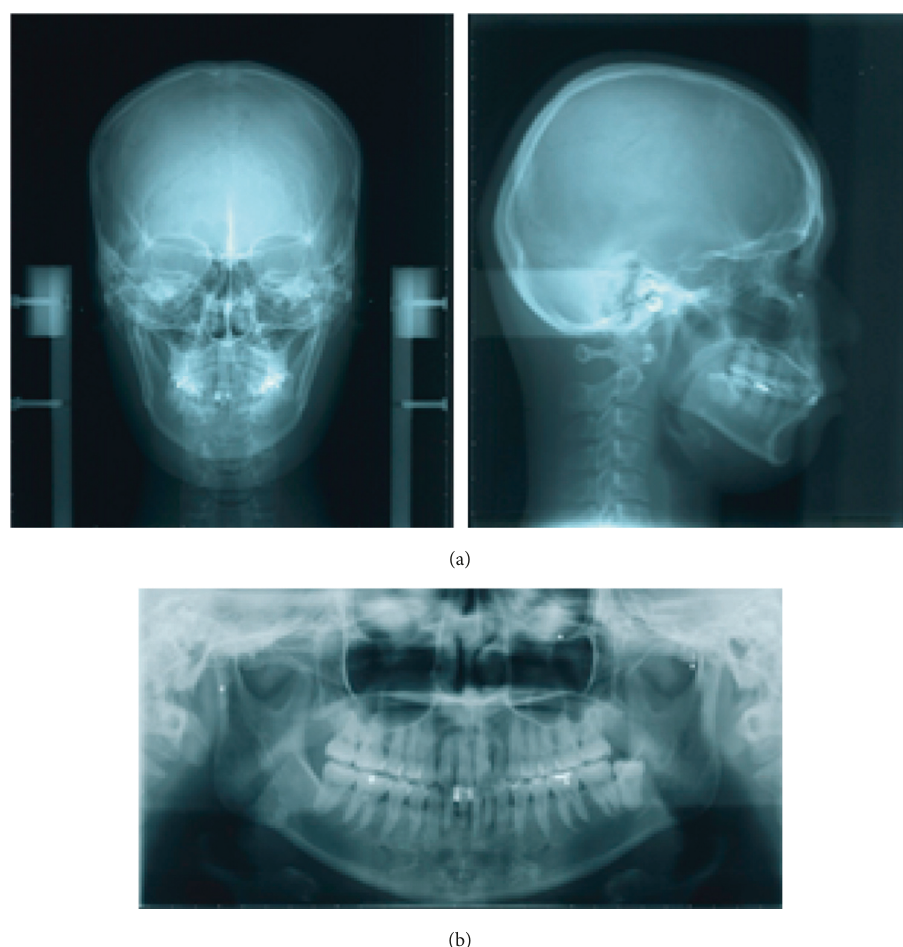
Figure 2: Pre-orthodontic treatment cephalograms (a) and panoramic radiograph (b) are shown.